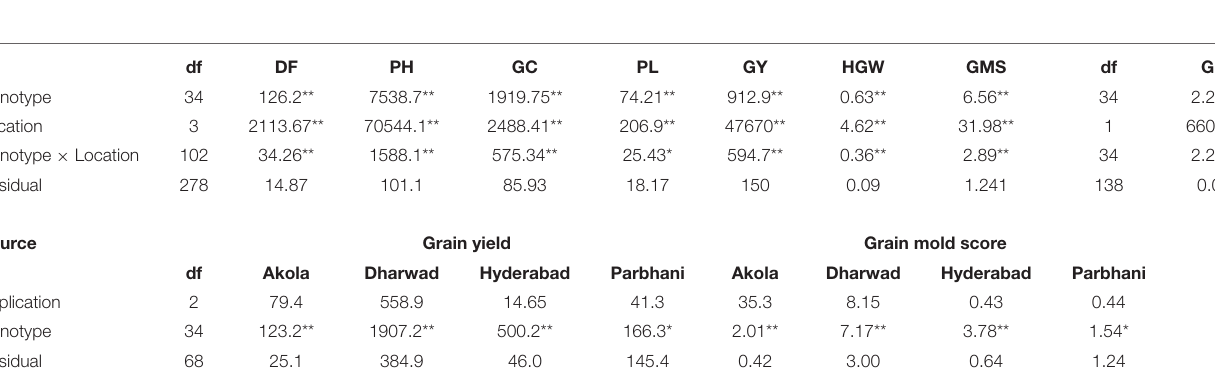
TABLE 2 | (A) ANOVA for different studied traits across four locations during the rainy season of 2018. (B) ANOVA for grain yield and grain mold score in individual locations during rainy season of 2018. (A) df DF